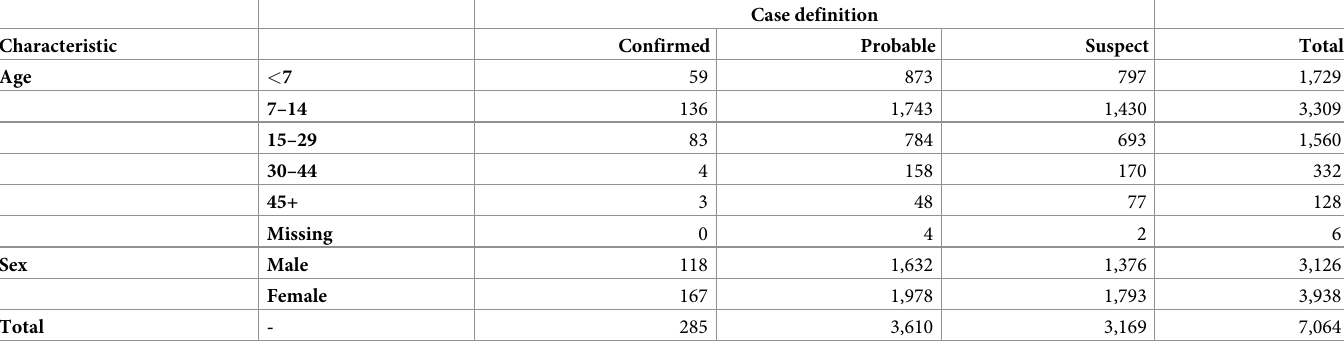
Table 1. Characteristics of diphtheria cases by case definition among Rohingya refugees, Cox’s Bazar, Bangladesh, November 10, 2017 to November 10, 2019.